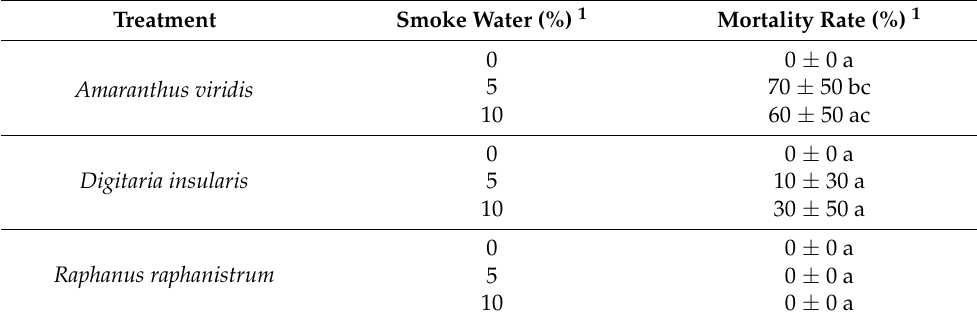
Table 5. Mortality percentage caused by smoke solutions in weeds.